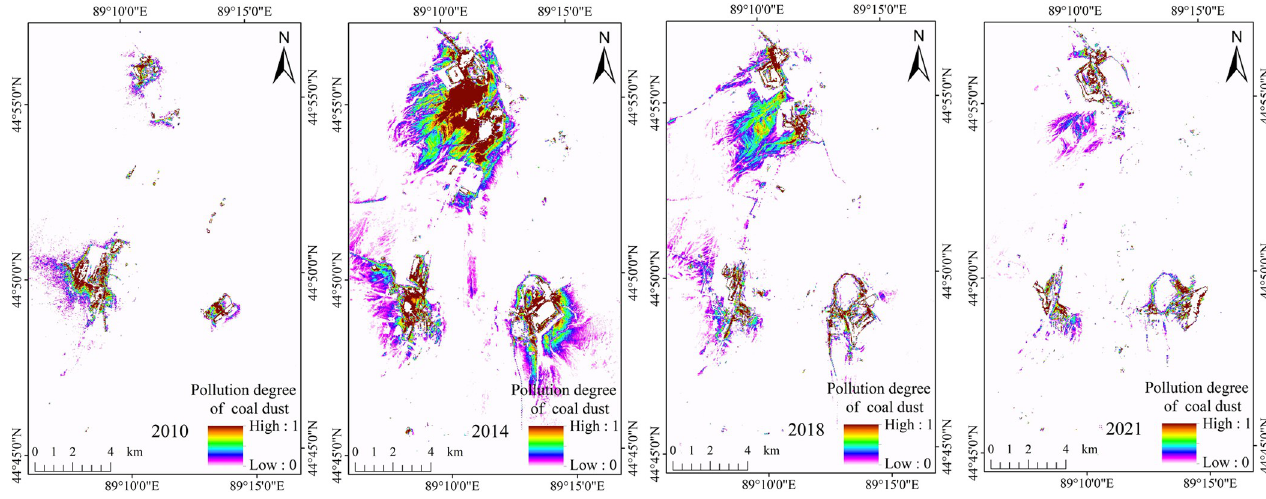
Fig 9. Dimidiate pixel model images of the ECDI in 2010, 2014, 2018, and 2021.